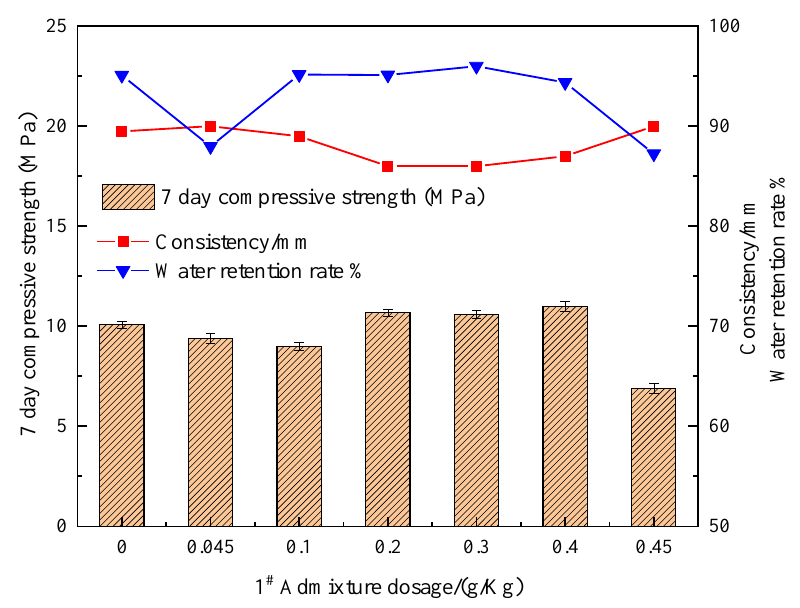
Figure 6. Effect of admixture content on properties of dry-mixed mortar.